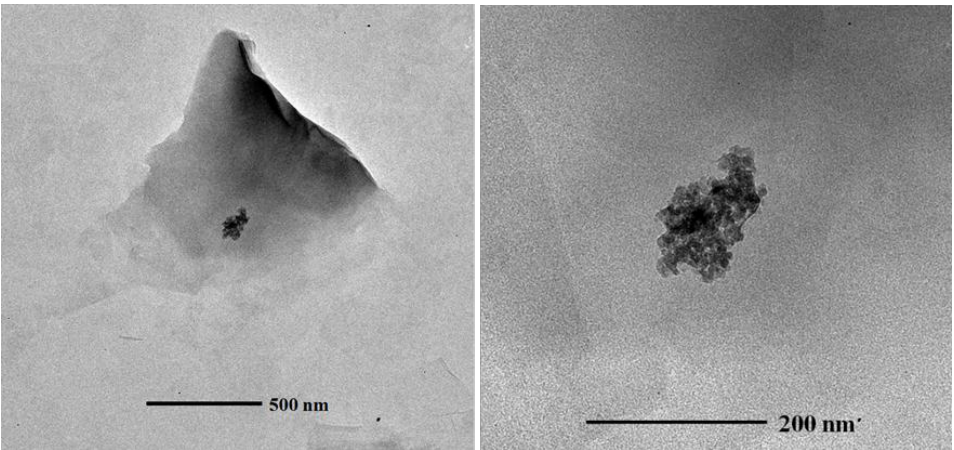
Figure 6. Bright field TEM images of 10 nm γ-Al 2 O 3 NPs with montmorillonite at pH < PZC of Al 2 O 3 NPs.